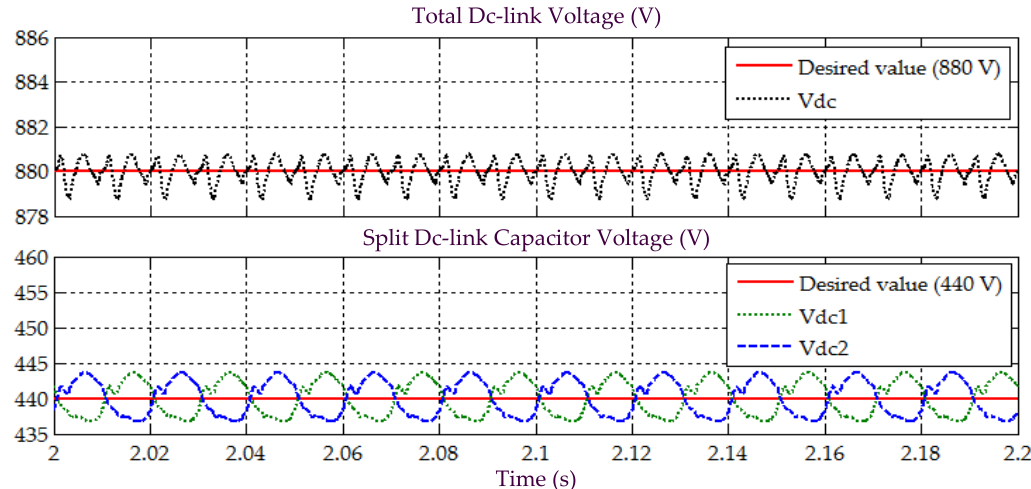
Figure 23. Simulation results obtained under Scenario D for Load 2, which include three-phase source voltage 𝑣 𝑆𝑎𝑏𝑐 , load current 𝑖 𝐿𝑎𝑏𝑐 , injection current 𝑖 𝑖𝑛𝑗𝑎𝑏𝑐 , source current 𝑖 𝑆𝑎𝑏𝑐 , and neutral current before and after mitigation, demonstrated by SAPF while applying the ( a ) proposed STF- dq 0 and ( b ) standard dq 0 techniques.